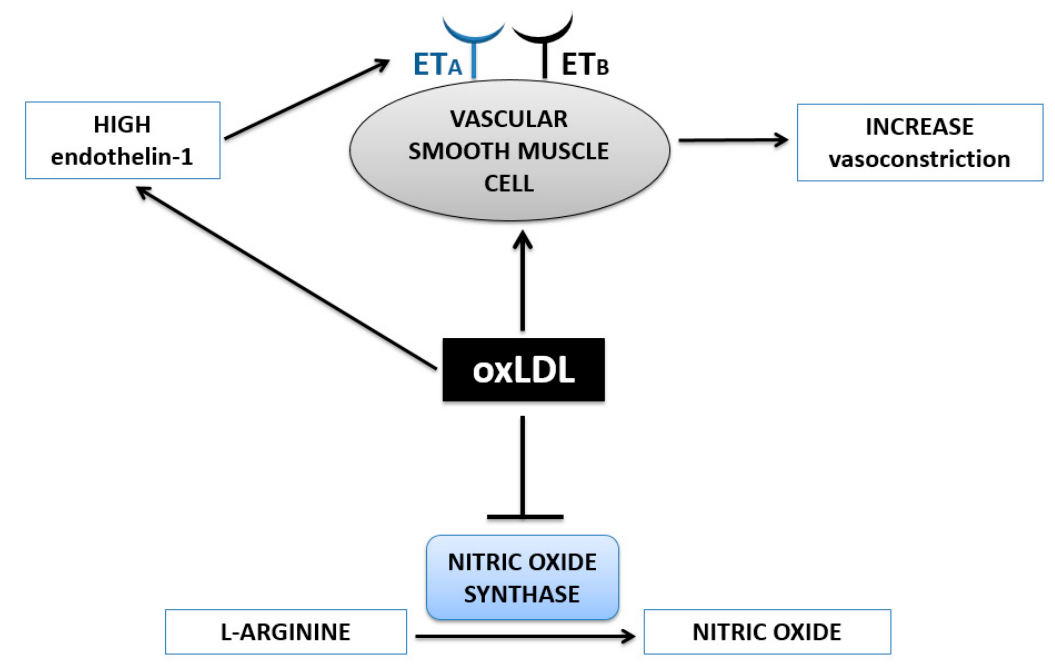
Figure 4. Accumulation of oxidized, low density lipoprotein (oxLDL) in plaque induces vasoconstriction in two ways – upregulation of endothelin-1 expression and inhibition of nitric oxide synthase enzyme. Abbreviations: ET A —endothelin receptor A, ET B —endothelin receptor B.